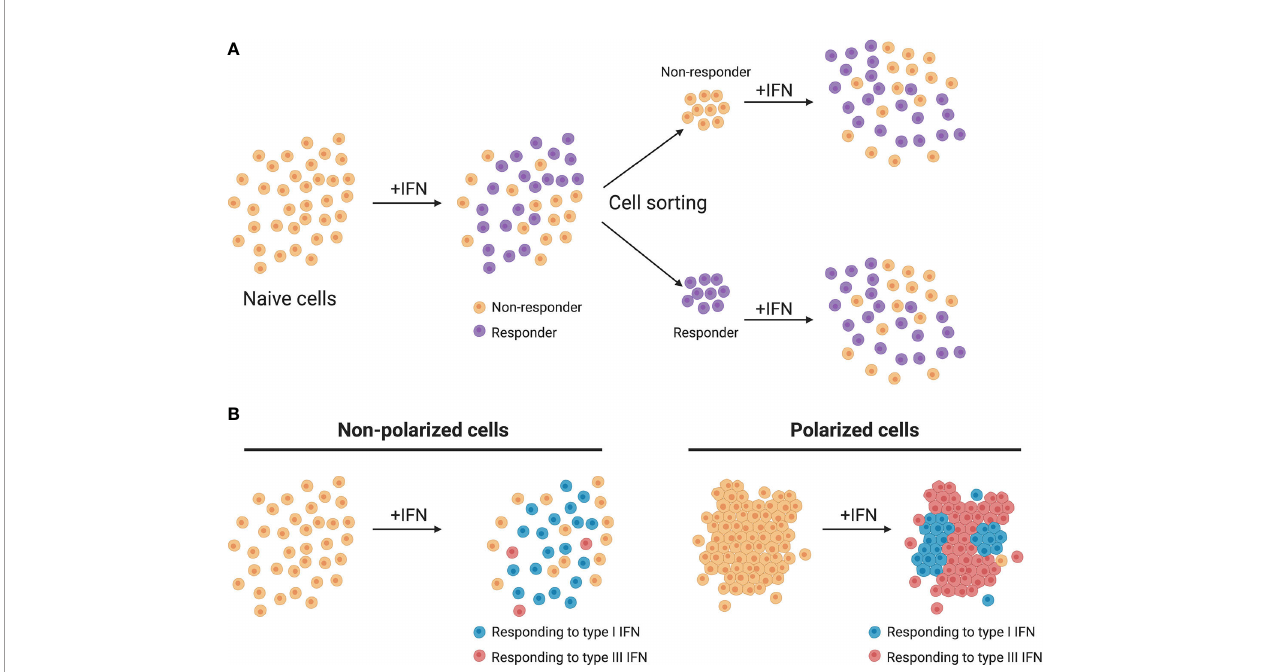
FIGURE 3 | Heterogeneity of IFN production and response. (A) Homogeneous cell cultures treated with IFN (+IFN) respond in a heterogeneous manner. Upon sorting and restimulation with IFN, non-responding cells display a similar distribution of responding cells as the naive population. (B) In murine models, non-polarized cells respond mainly to type I IFNs while polarized cells respond mainly to type III